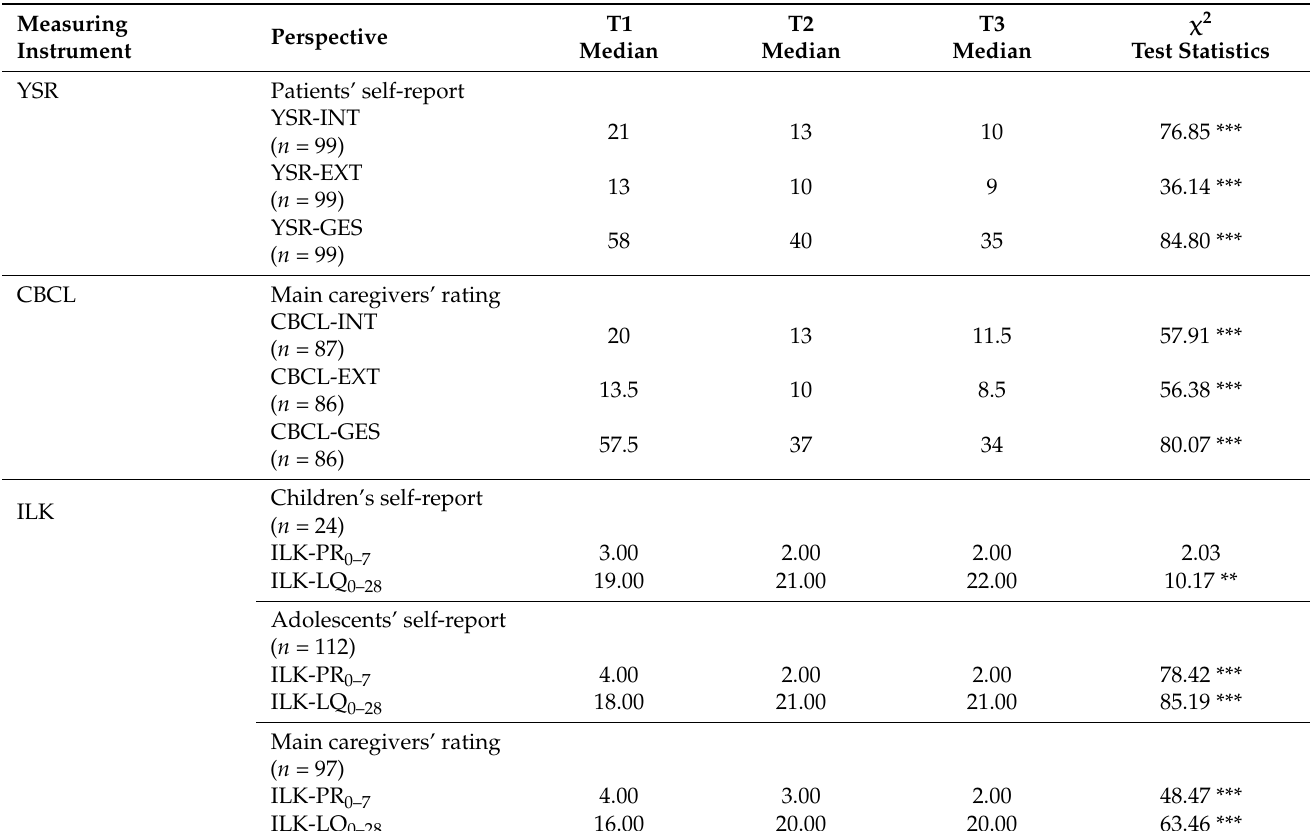
Table 2. Treatment success and quality of life over time and results of significance